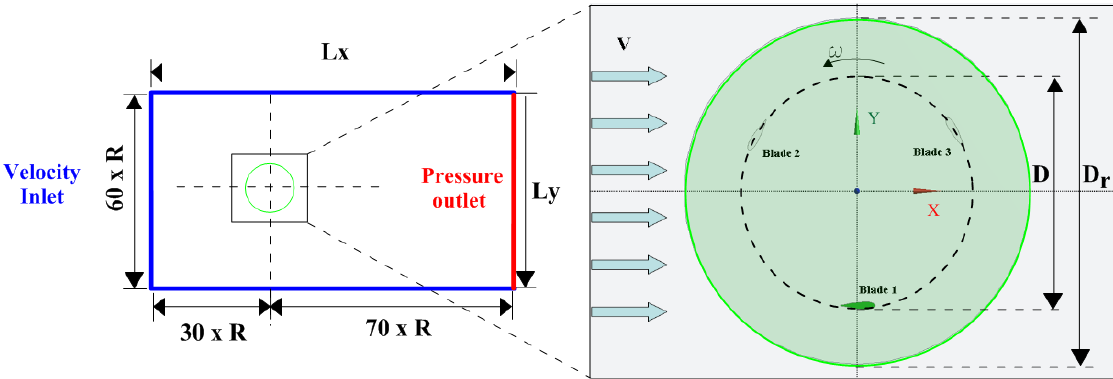
Figure 1. Two-dimensional computational